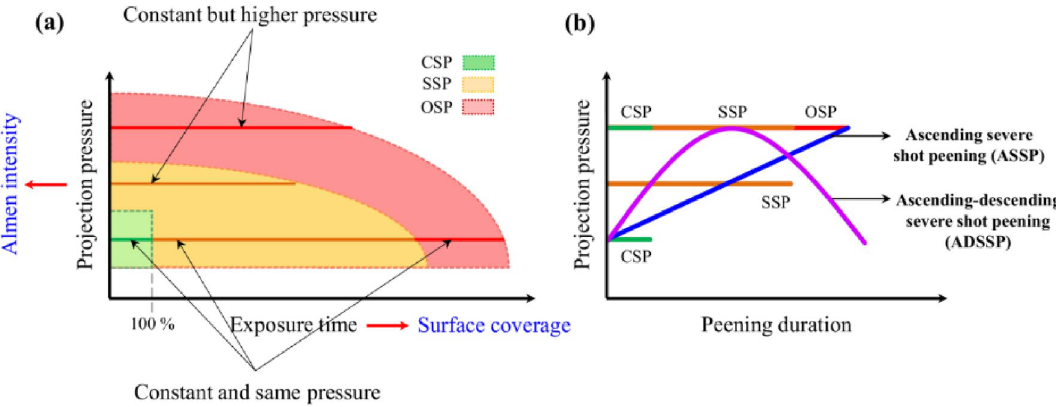
Figure 2. Schematic illustration representing ( a ) the comparsion of CSP, SSP and OSP in terms of projection pressure and peening duration and ( b ) variations of projection pressure through the peening duration in novel GSSP treatments of ASSP and ADSSP compared to CSP, SSP and OSP treatments.